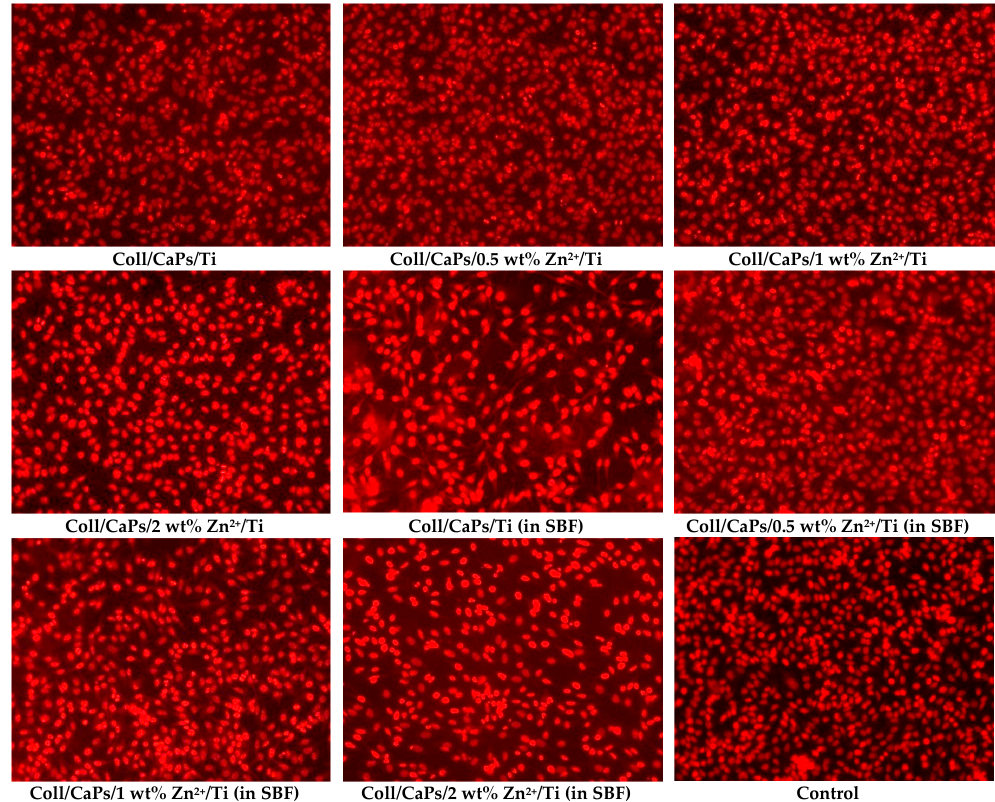
Figure 10. Fluorescent microscopy images of cells grown on Coll/Zn(II)-CPs thin films deposited on Ti by MAPLE.